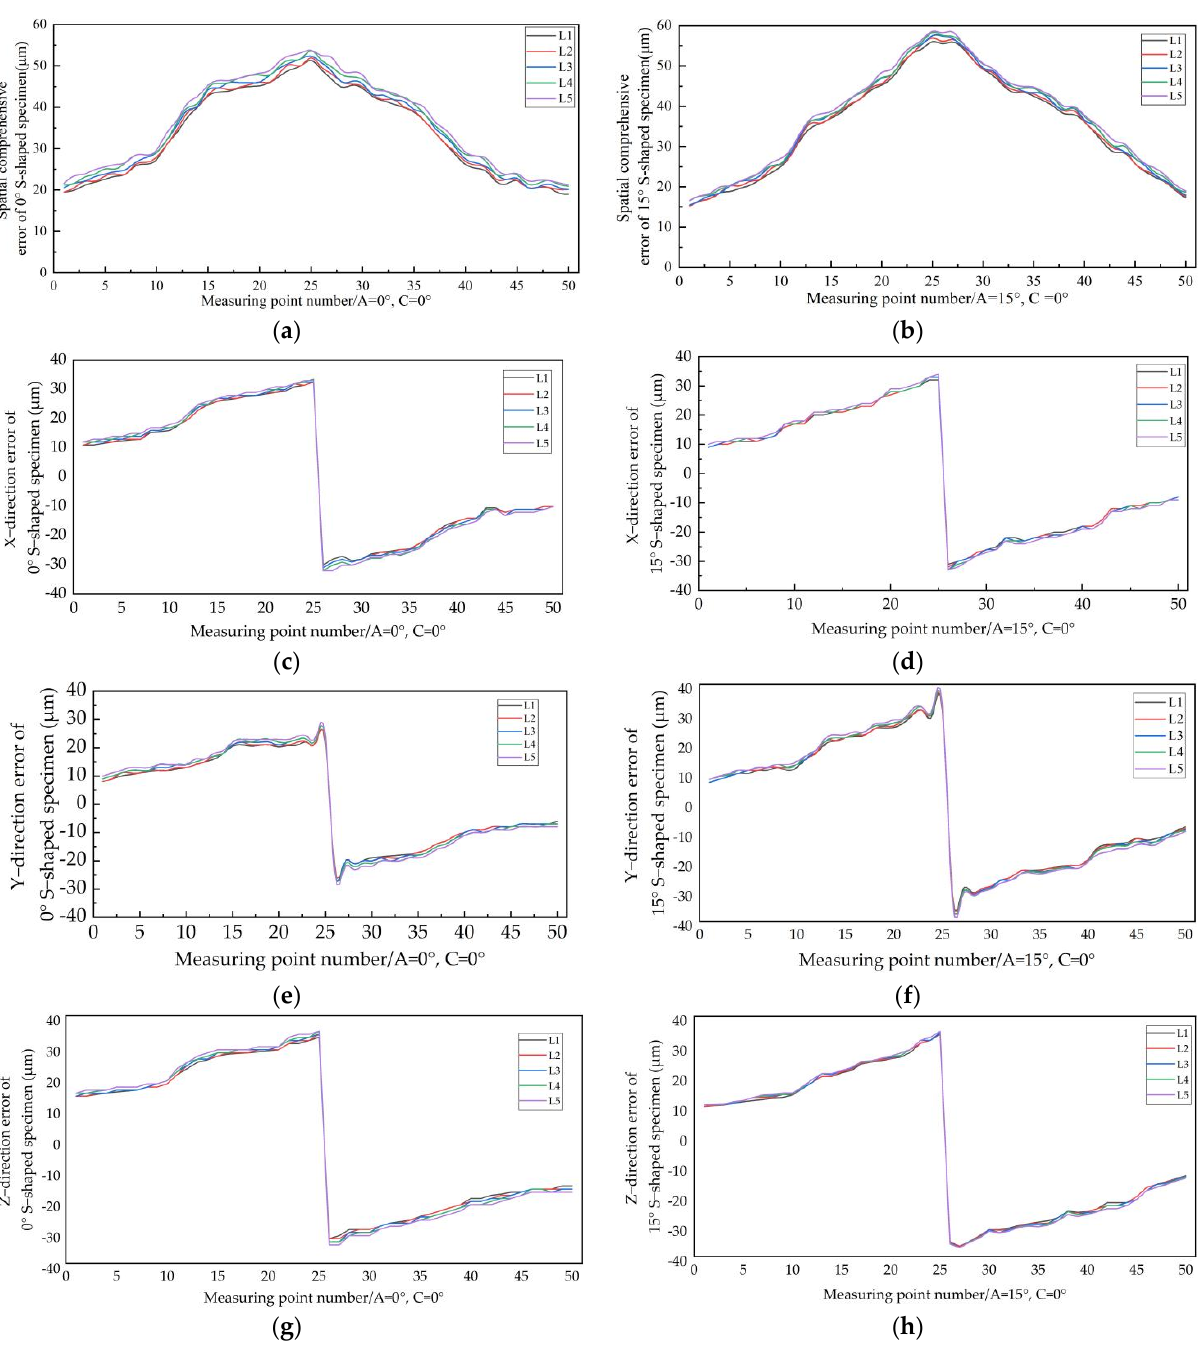
Figure 9. Different curved surface inclination angles for comprehensive error of S-shaped specimen at ( a ) 0° and ( b ) 15°, and X-direction error of S-shaped specimen at ( c ) 0° and ( d ) 15°, and Y direction error of S-shaped specimen at ( e ) 0° and ( f ) 15°, and Z direction error of S-shaped specimen at ( g ) 0° and ( h ) 15°.